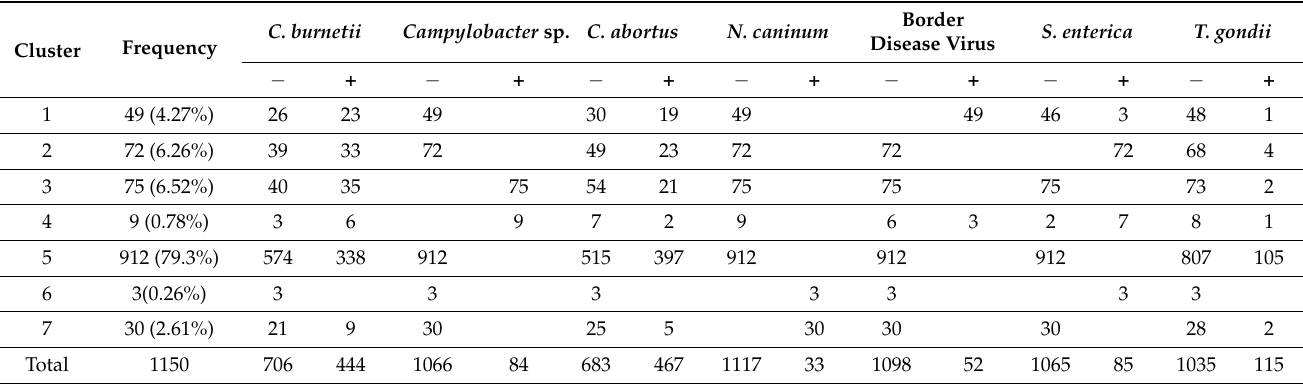
Table 4. Characteristics of samples from 1150 ovine abortions included in the seven clusters obtained in the study.